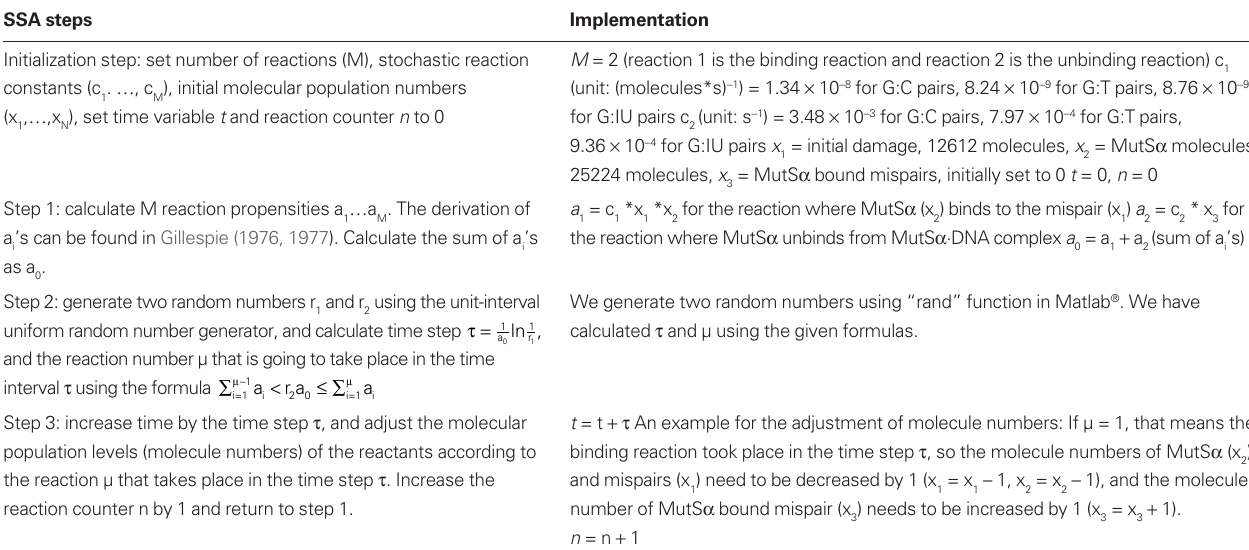
Table 2 | The steps in the SSA algorithm and the implementation